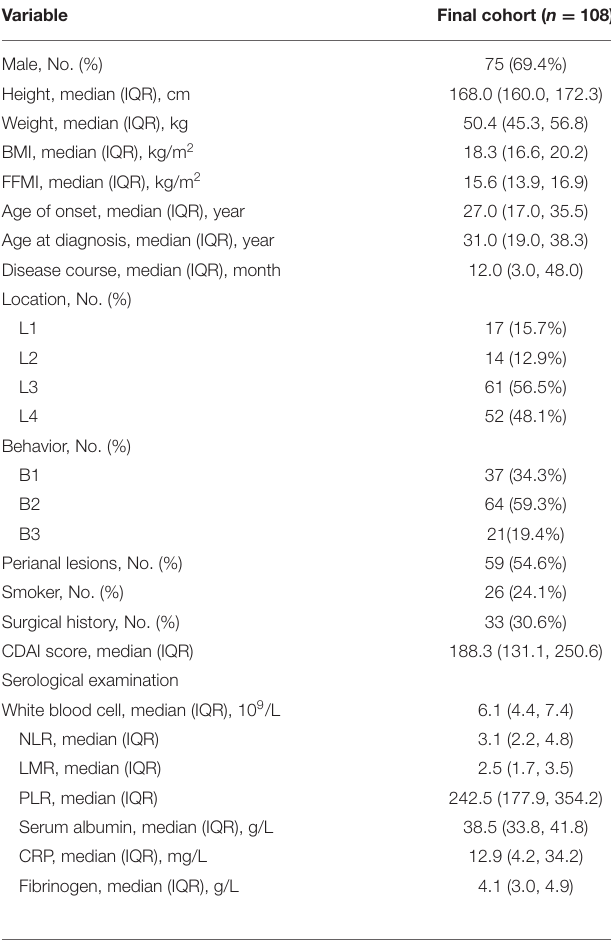
TABLE 1 | Baseline characteristic of final